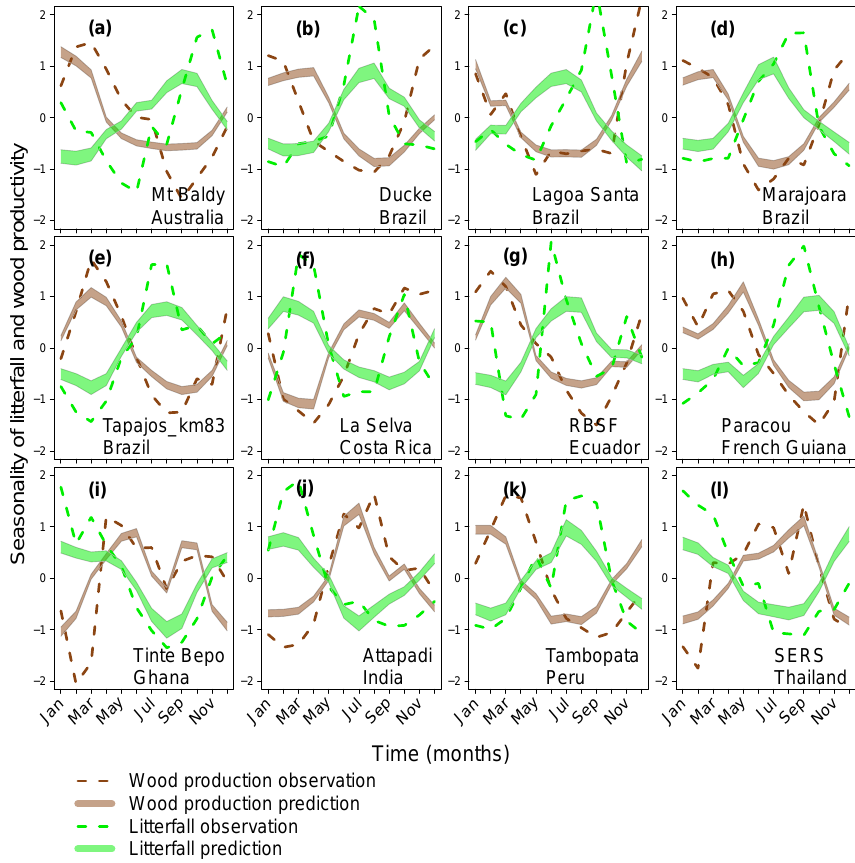
Figure 9. Observations and predictions of wood productivity and litterfall seasonality in sites where both measurements were available. The outliers in our analysis, Lambir and Caracarai, are not represented. y axis have no units as the variables were normalized.